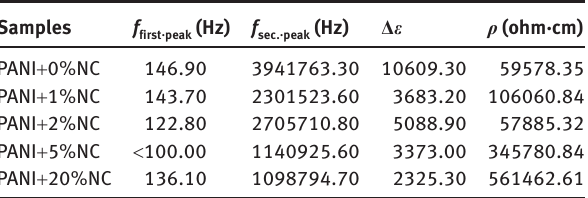
Table 1: Maximum peak frequency values at dissipation plots, dielectric strength and surface resistivity. Samples